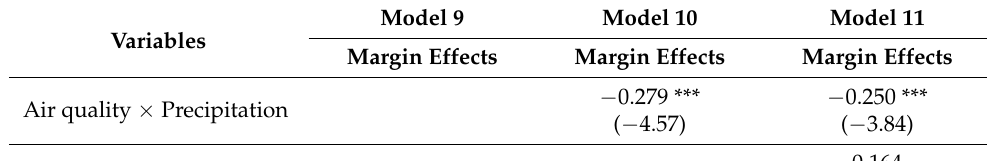
Table 5. The interaction effects of natural amenity on elderly migrants’ settlement